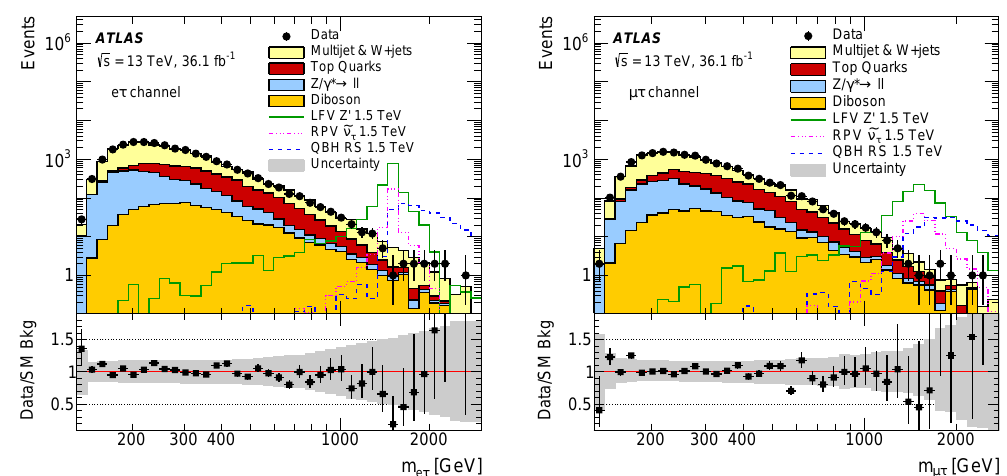
Figure 6: The final di-lepton mass distributions for e τ and µτ searches [ 20 ] . The various signal models to generate LFV are represented by unfilled, unstacked his- tograms.